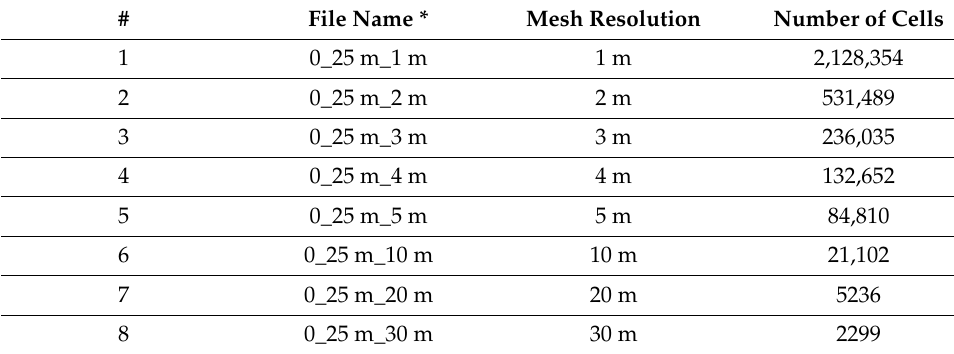
Table 5. Mesh resolution and number of cells for each computational